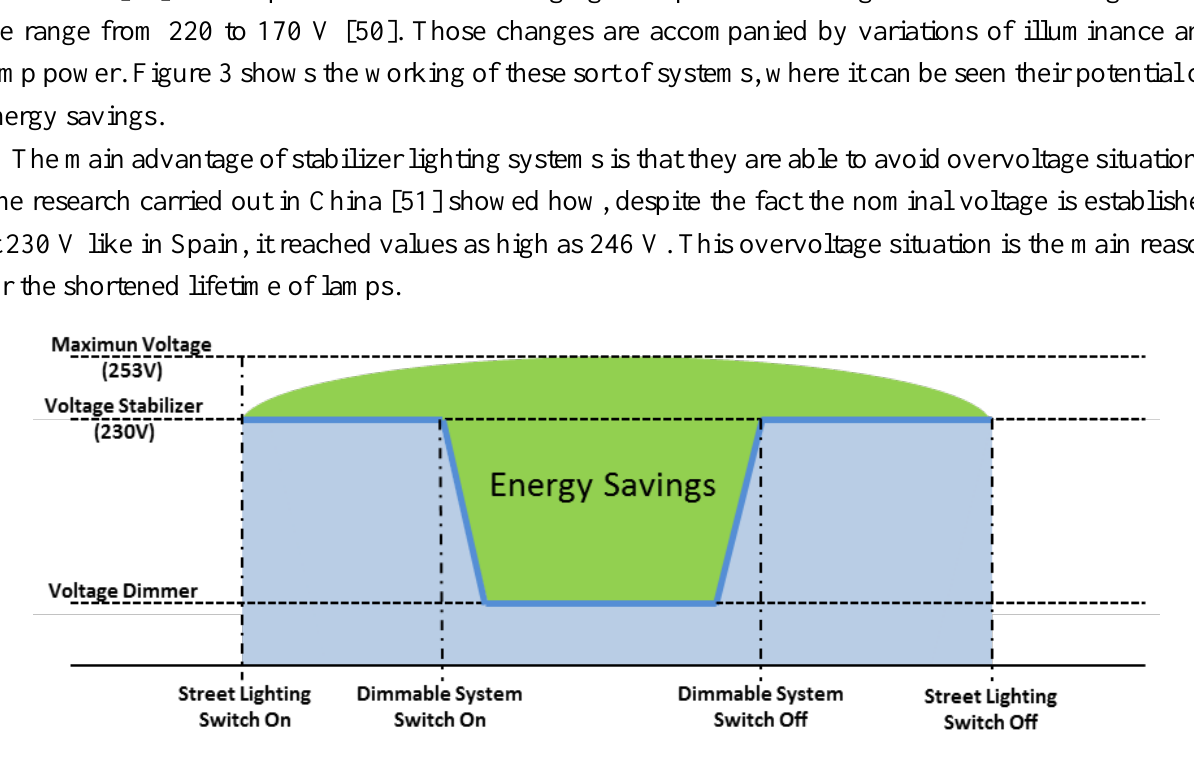
Figure 3. Regulator and stabilizer devices.